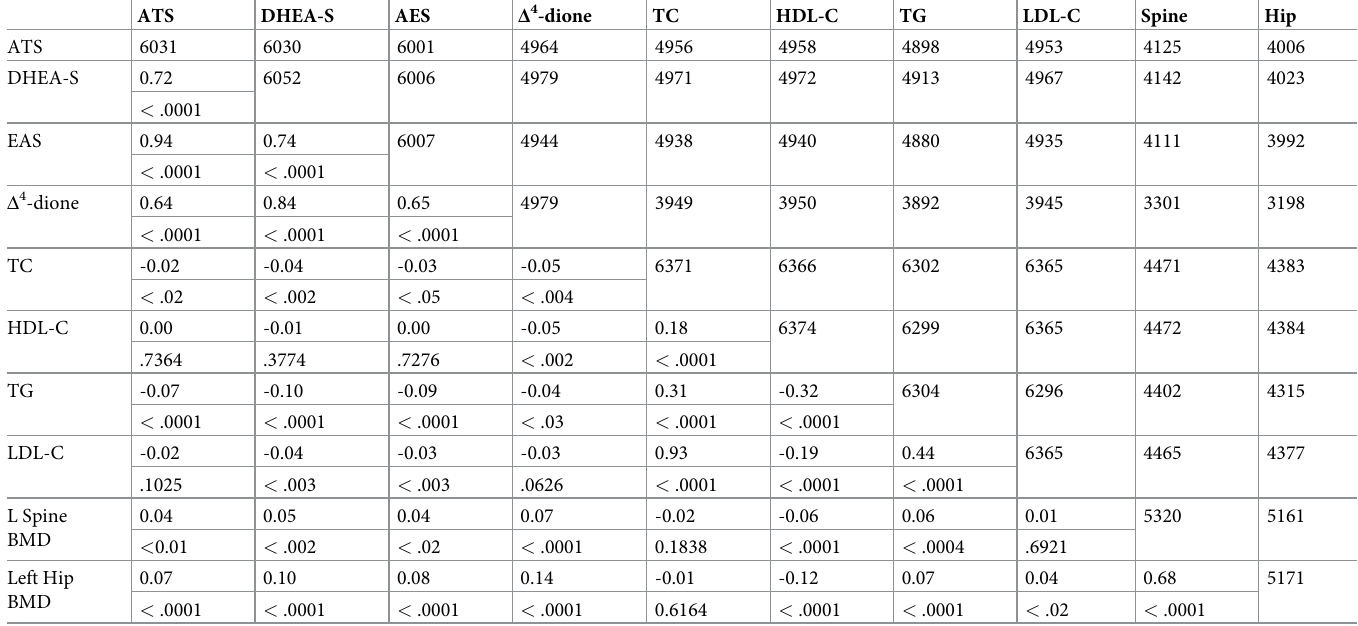
Table 1. Phenotypic correlations.